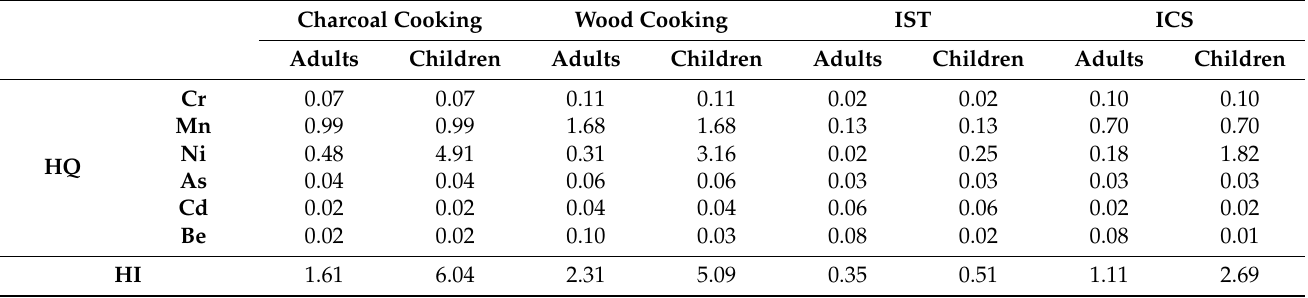
Table 2. Non-carcinogenic risks of toxic metals in different particulate matter samples collected by in situ samplings for adults and children. IST: insecticides; ICS: